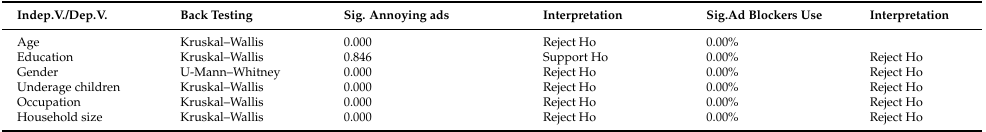
Table 5. Impact of variables when deciding if advertising is annoying and the use of blockers, 2019. Indep.V./Dep.V.